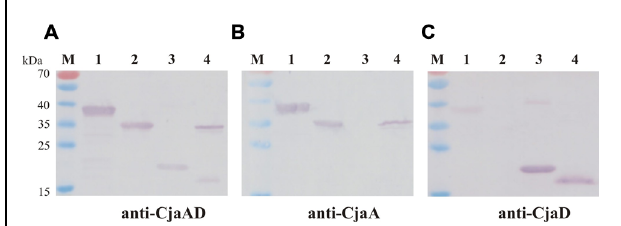
FIGURE 4 | Western blot analysis of the specificity of rCjaAD. Protein extracts were separated by 12% SDS-PAGE under reducing conditions and probed with: (A) anti-rCjaAD antibodies, (B) anti-CjaA antibodies, (C) anti-CjaD antibodies. Lanes: 1 – purified protein 6xHis-rCjaAD-6xHis, 2 – purified protein 6xHis-CjaA; 3 – purified protein 6xHis-CjaD; 4 – C. jejuni cell lysate, M - protein molecular-weight marker.